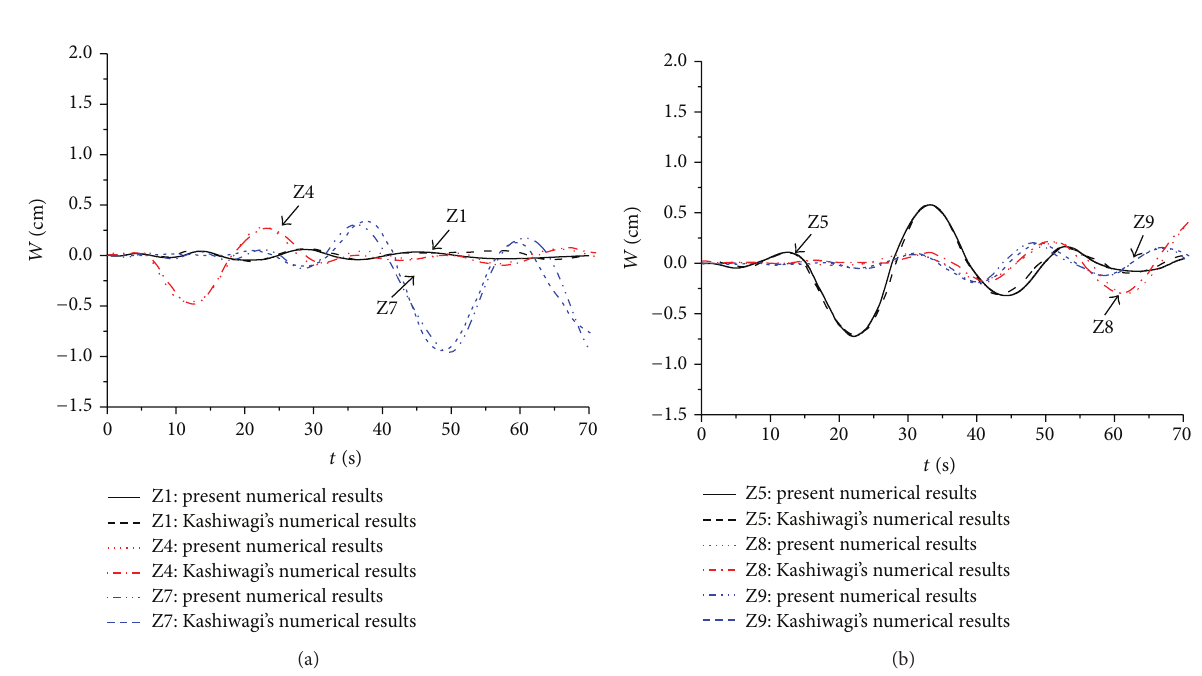
Figure 9: Spatial profiles of the VLFS during the mass drop in regular wave conditions.